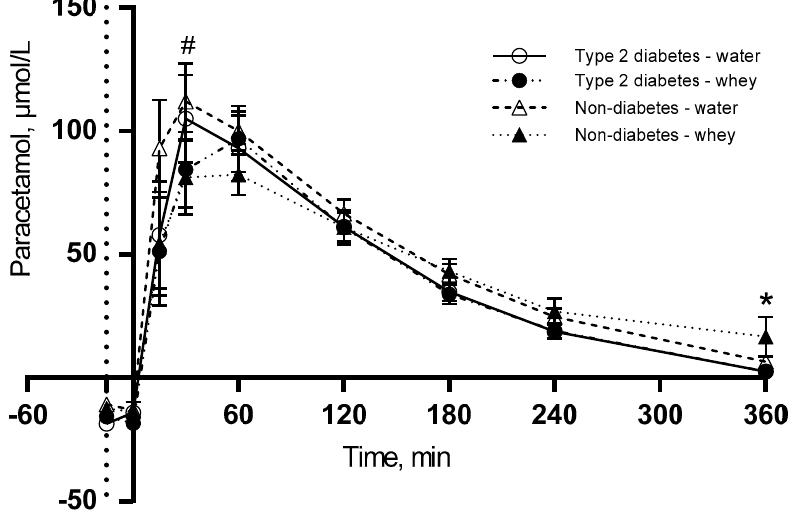
Figure 4. Postprandial responses for S-paracetamol. 12 T2D and 12 non-diabetic subjects were observed after consumption of 20 g whey proteins (WP) or water as a pre-meal 15 min prior to a fat-rich meal in. Dotted vertical line (y = − 15) indicates pre-meal consumption. Data are presented as mean ± SEM, n = 24. * indicates differences between subjects with and without type 2 diabetes. # indicates differences between pre-meals (WP and water). ANOVA for repeated measurements was used to examine the effect of diabetes, intervention and time on the postprandial response.